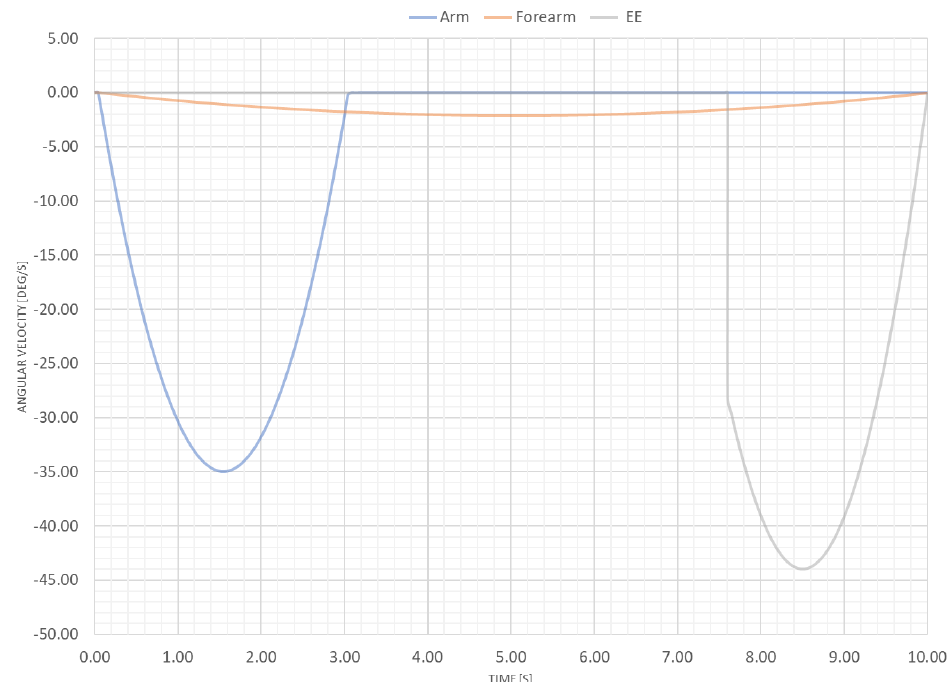
Figure 5. Computed results for the kinematic simulation in Figure 4 in terms of angular velocities. Figure 6 illustrates the computed angular accelerations of the three arm segments.